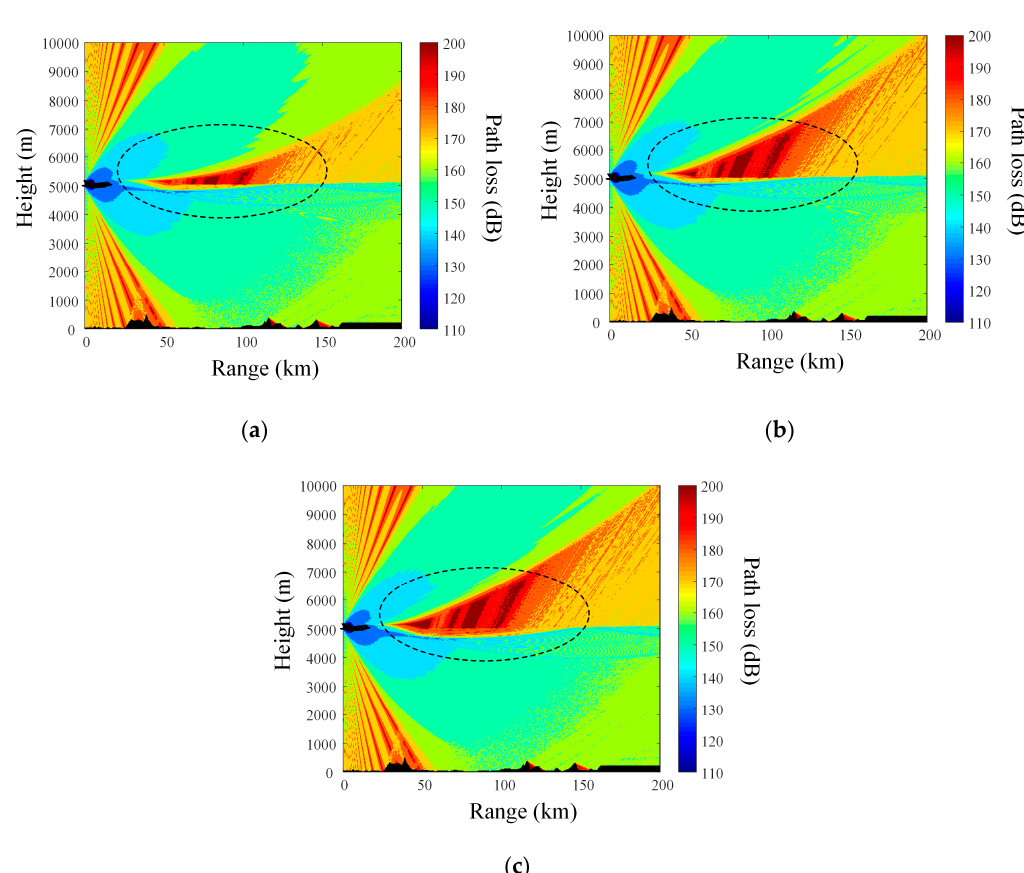
Figure 6. The Advanced Refractive Effects Prediction System (AREPS) simulation results of path losses employing the linear models and the actual data regarding the modified refractivity: ( a ) trilinear model; ( b ) quad-linear model; ( c ) actual data.